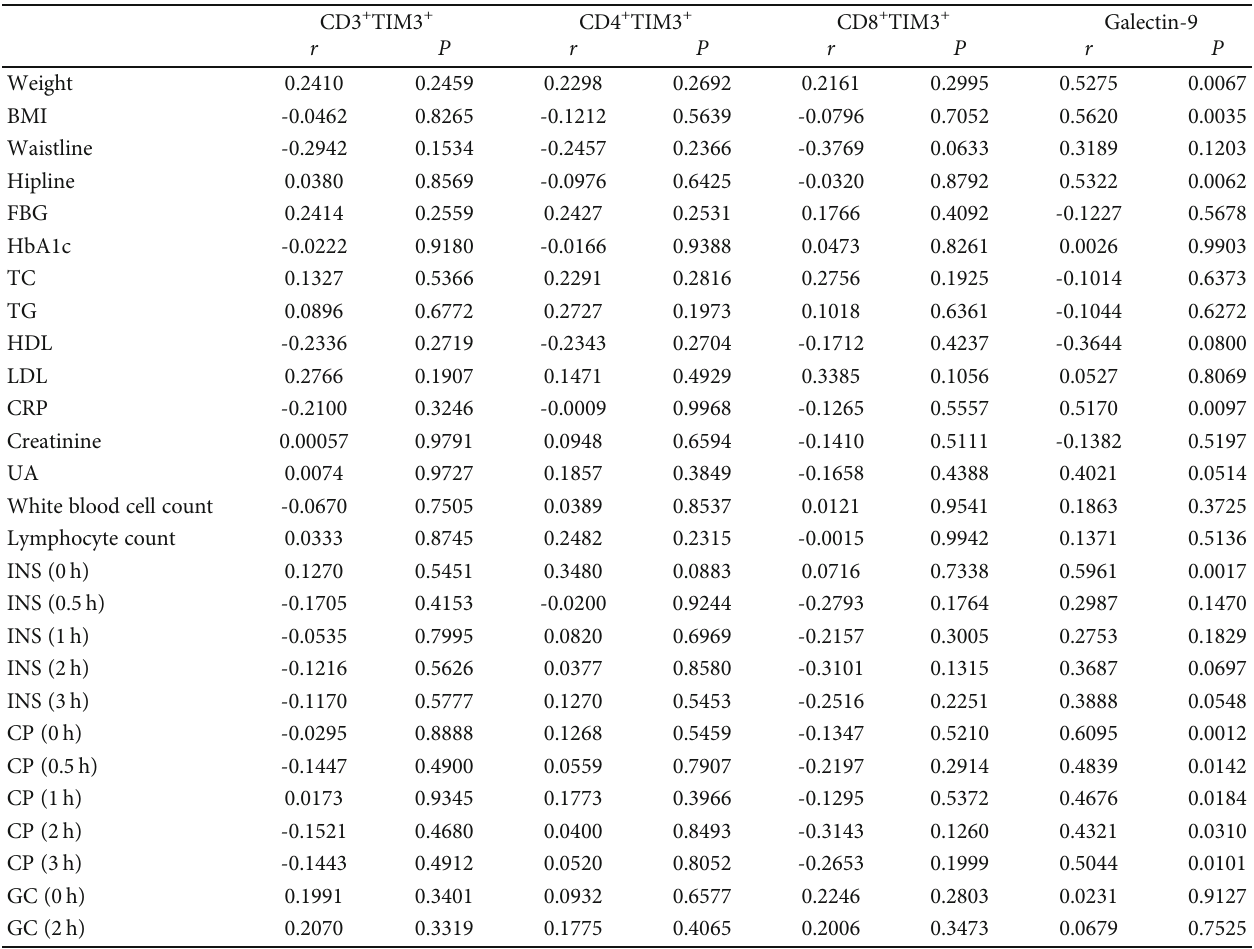
Table 3: Correlation between TIM3, galectin-9, and clinical indicators in obesity comorbid T2DM patients. CD3 + TIM3